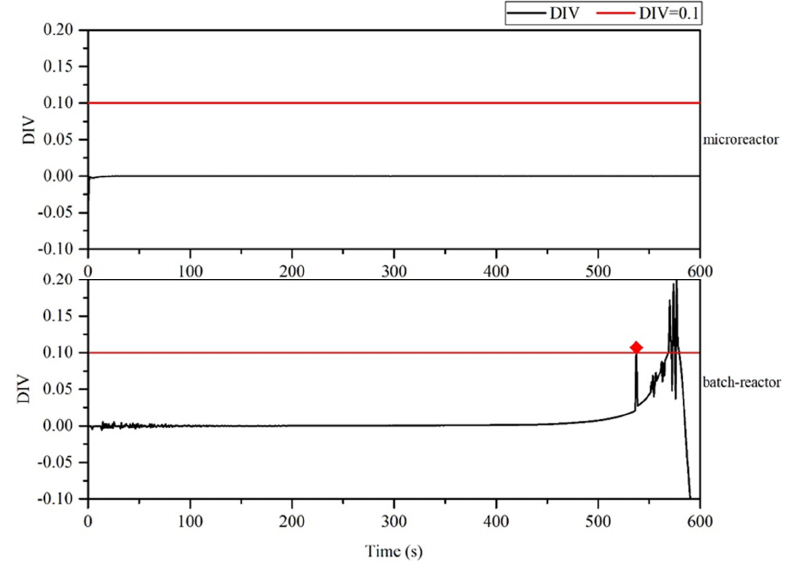
Figure 6. Divergence criterion (DIV) diagram of temperature monitoring in the batch reactor and microreactor.